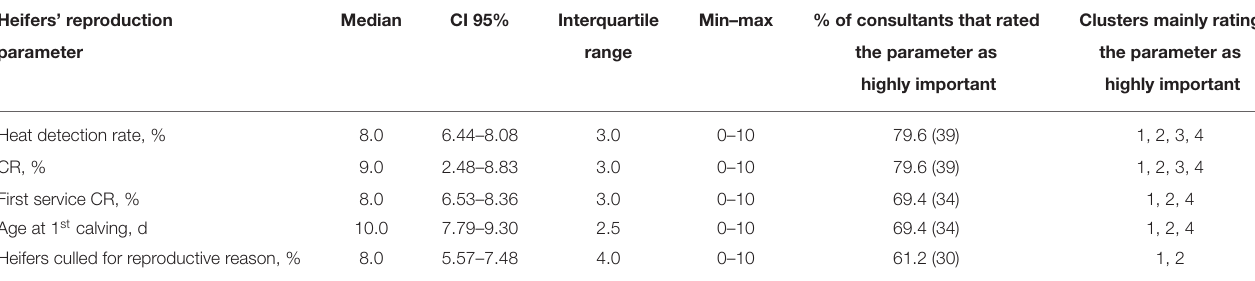
Heifers culled for reproductive reason,